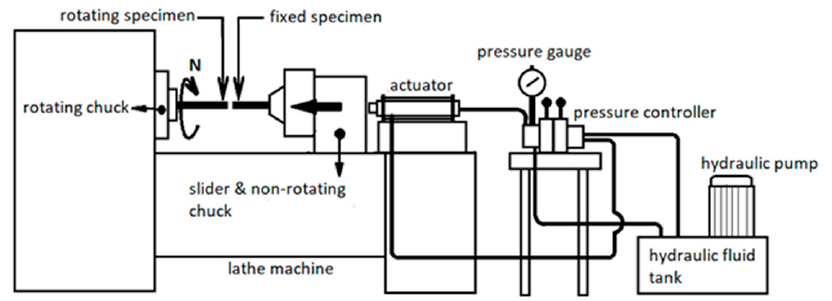
Figure 1. Lathe machine equipped with hydraulic pack for RFW process. A fixture was installed on a lathe for the welding process. It was located on the machine guideways and could be moved toward the spindle. This equipment was designed so the center of the specimen holder was aligned with the center of the spindle to maintain the axial alignment of the two specimens. The fixed sample holder was installed in a sleeve cylinder so that it could slide and move axially. The position of the device was fixed using a bolted clamp when the required position was reached so that it could resist the force during welding. Additionally, the length of the free end of the specimen was adjusted to avoid excessive vibration and maintain the axiality of the force. Prior to welding, the positions of both specimens were adjusted so that their faces were at around a 1–3 mm distance. Then, the axial force was supplied by the hydraulic piston rod of the power pack unit to provide interfacial contact between the specimens. The 304 SS was used as a fixed specimen in the RFW experiments, while the carbon-steel sample was placed on the spindle of the machine and rotated continuously. Based on the implemented experimental design, two welding processes were performed for each experimental